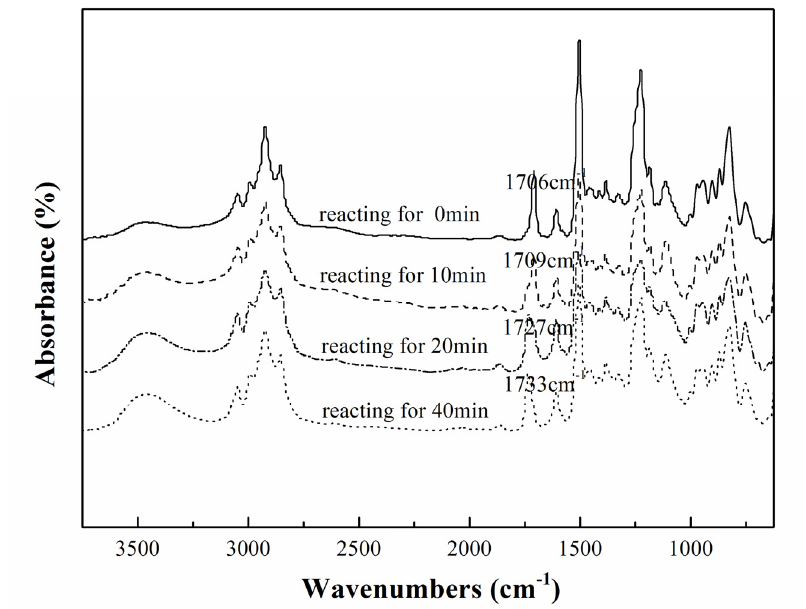
Figure 2. The chemical shifts of the modification process of 6%DFA-TGDDE